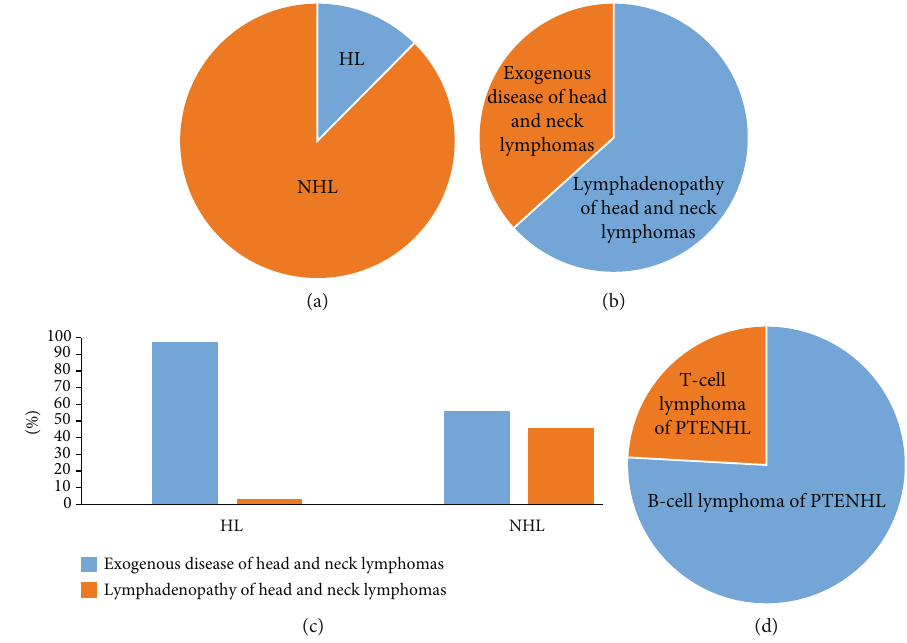
Figure 1: Clinical characteristics of extranodal non-Hodgkin ’ s lymphoma in the head and neck region: (a) proportion of all lymphomas; (b) lymphadenopathy or exogenous disease proportion of head and neck lymphoma; (c, d) two major categories and two subtypes of PENHL in the head and neck region. PENHL: primary extranodal non-Hodgkin ’ s lymphoma; HL: Hodgkin ’ s lymphoma; NHL: non-Hodgkin ’ s